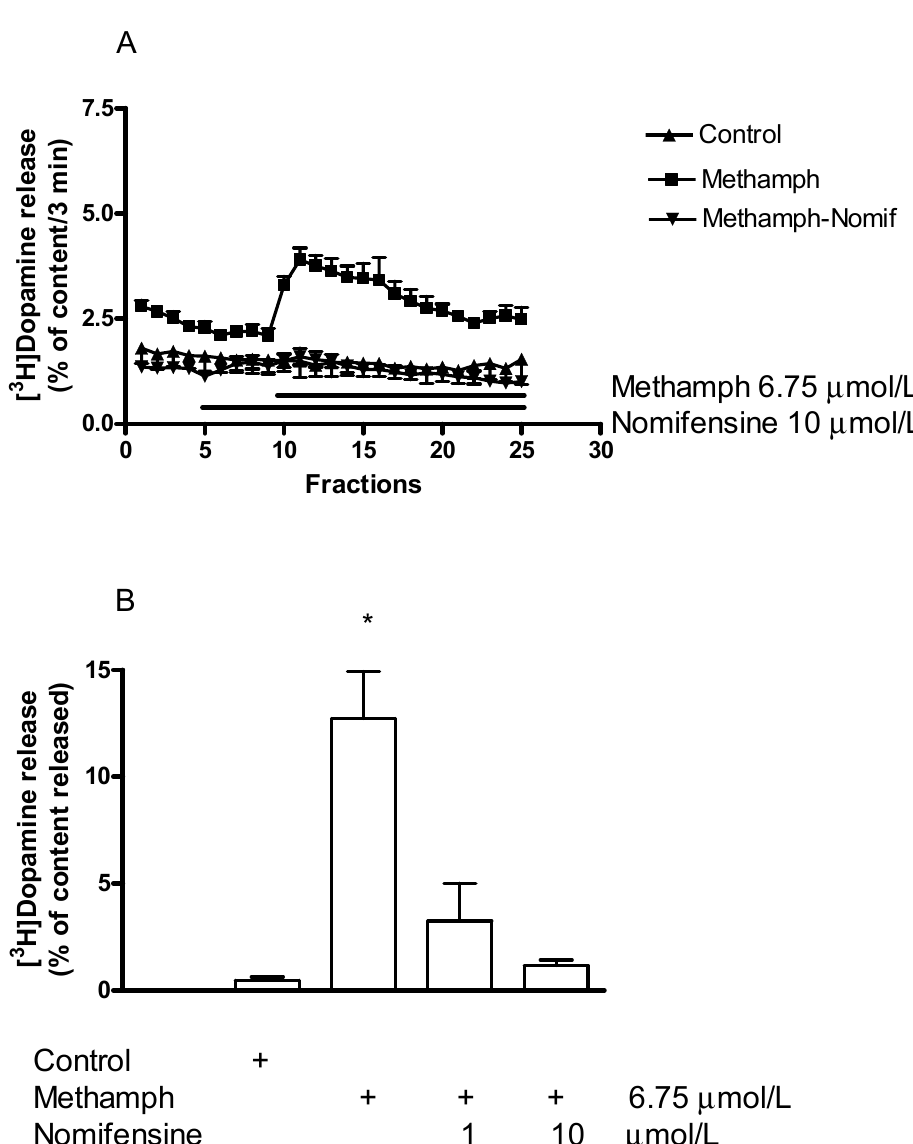
Figure 8. ( A ) Nomifensine (Nomif) reversed the (±)methamphetamine (methamph)-induced [ 3 H]do- pamine release from rat striatum. For the experimental procedure, see Figure 2B.